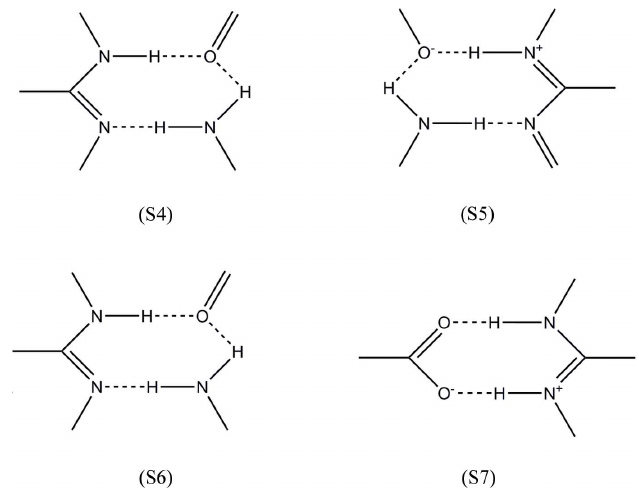
Figure 20 Supramolecular synthons between 1 and solvent, and 1 and coformer molecules observed in this